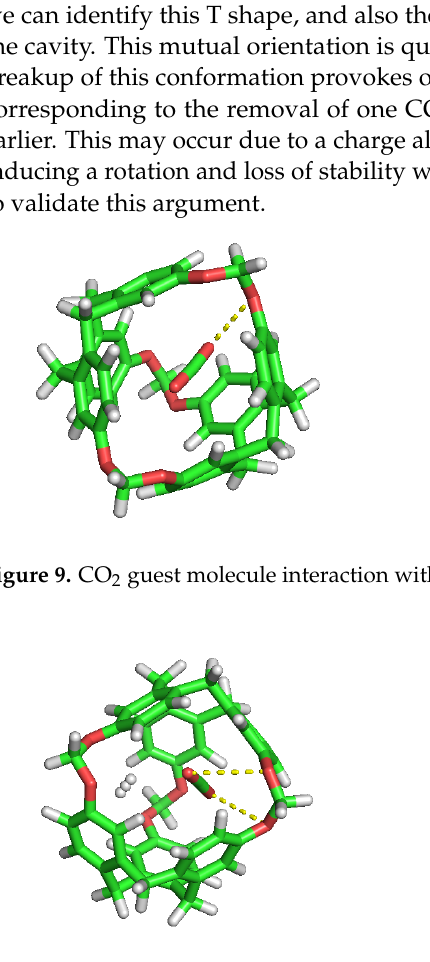
Figure 10. CO 2 and H 2 inside the cavity, showing their polar interactions.